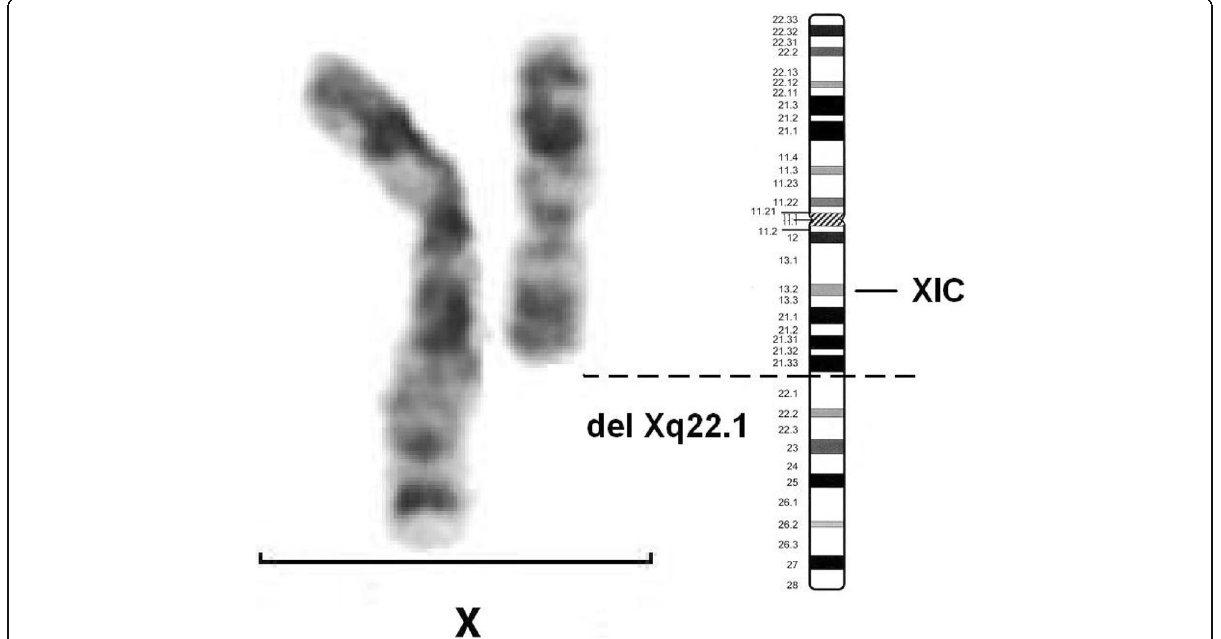
Fig. 3 Xq22.1 deletion in the girl (GTG-banding). XIC - X inactivation center, located proximal to the breakpoint; its presence suggests that the rearranged chromosome might be